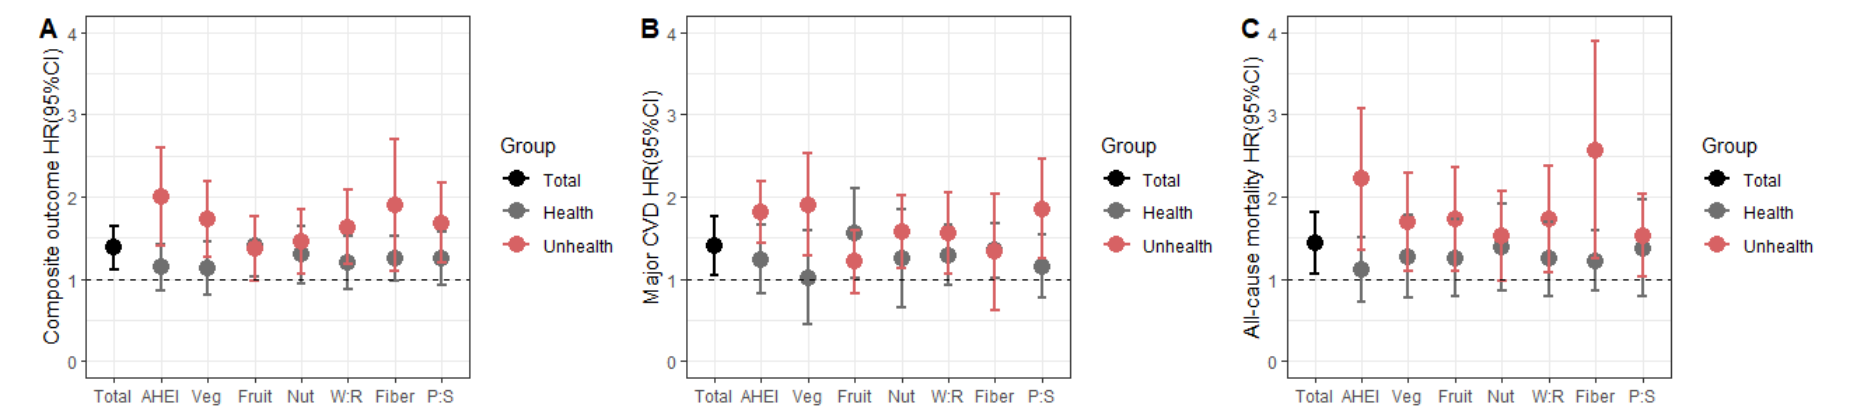
Figure 2. Subgroup analysis of the associations between depression and the outcomes by AHEI component. ( A ) Composite outcome, ( B ) Major CVD, and ( C ) All-cause mortality. ‘Health’ was considered that the AHEI component score (vegetable score, fruit score, nuts, and soy protein score, ratio of white to red meat score, cereal fiber score, and ratio of polyunsaturated to saturated fatty acids score (P:S)) over the lowest tertiles. In addition, ‘Unhealth’ was considered the AHEI component score below the lowest tertiles. The models were adjusted for age, gender, urban/rural regions, physical activities, education level, wealth index, social isolation index, self-reported disabilities score, current smoking, alcohol use, hypertension, diabetes, dyslipidemia, central obesity, use of statins, and center. Abbreviations: AHEI, Alternative Healthy Eating Index; CI, confidence interval; CVD, cardiovascular disease; HR, hazard ratio; P:S, ratio of polyunsaturated to saturated fatty acids score; W:R, ratio of white to red meat score.